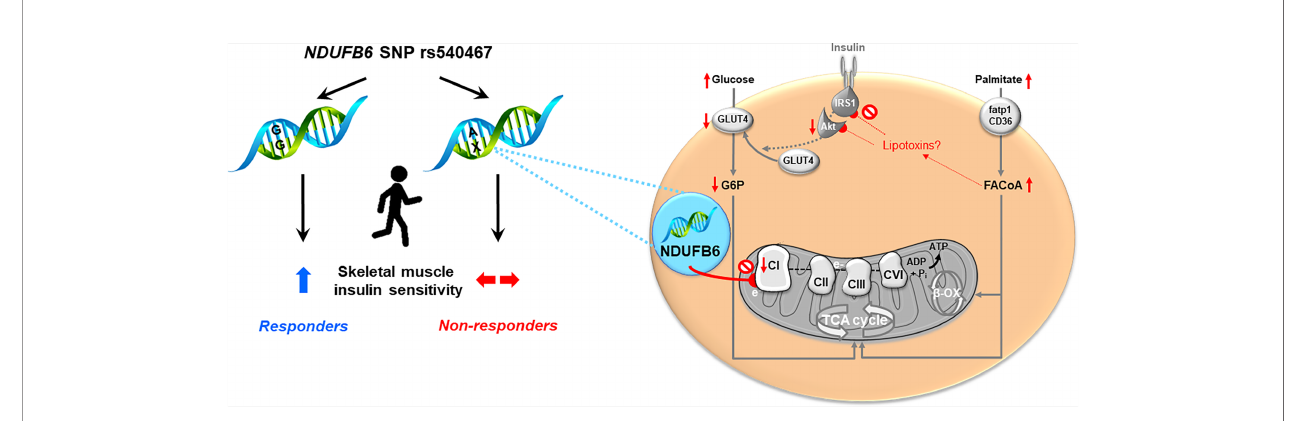
FIGURE 4 | Proposed framework of NDUFB6 interaction with physical activity-mediated improvement of